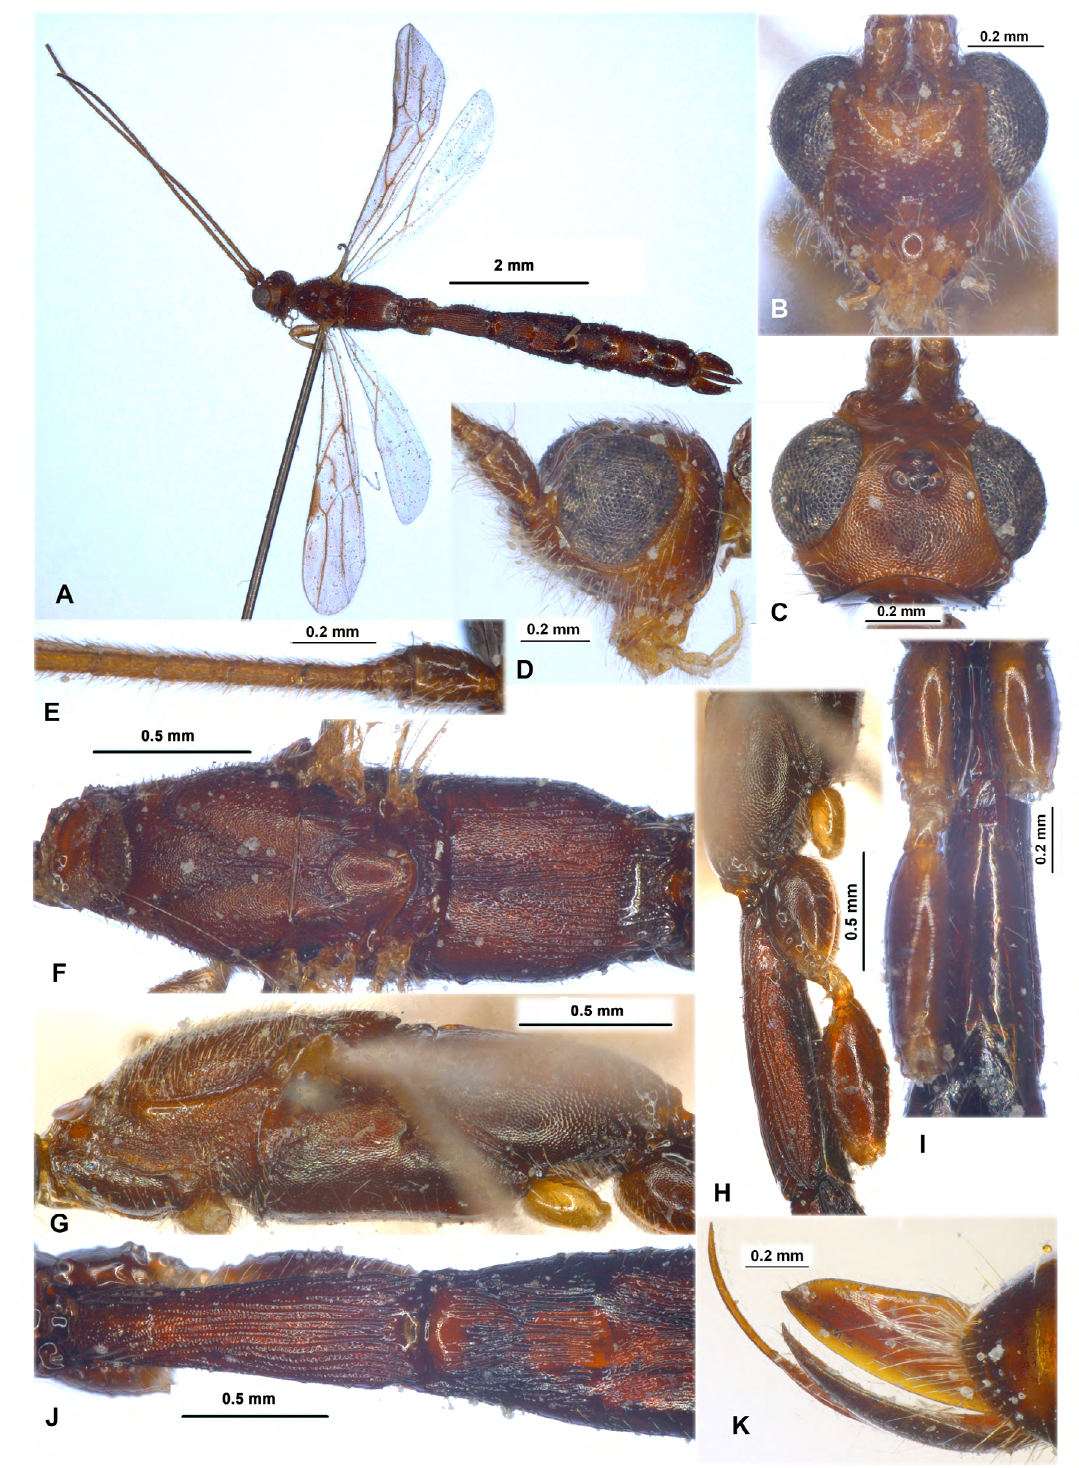
Fig. 22. Leptorhaconotus brunneus Granger, 1949, ♀, holotype, MNHN. A . Habitus, dorsal view. B . Head, front view. C . Head, dorsal view. D . Head, lateral view. E . Basal segments of antenna. F . Mesosoma, dorsal view. G . Mesosoma, lateral view. H . Propodeum, first metasomal tergite, hind coxa and femur, lateral view. I . Hind coxae and first metasomal tergite, ventral view. J . First to third metasomal tergites, dorsal view. K . Ovipositor with sheaths, dorso-lateral